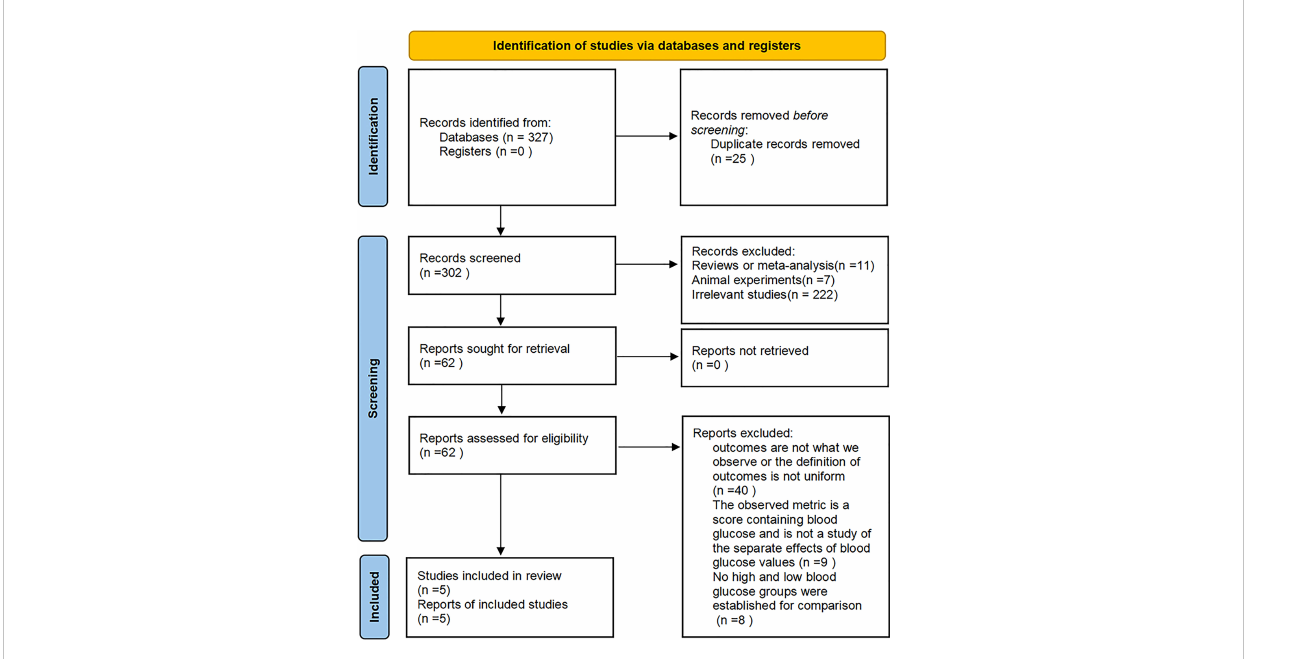
FIGURE 1 Flowchart of study